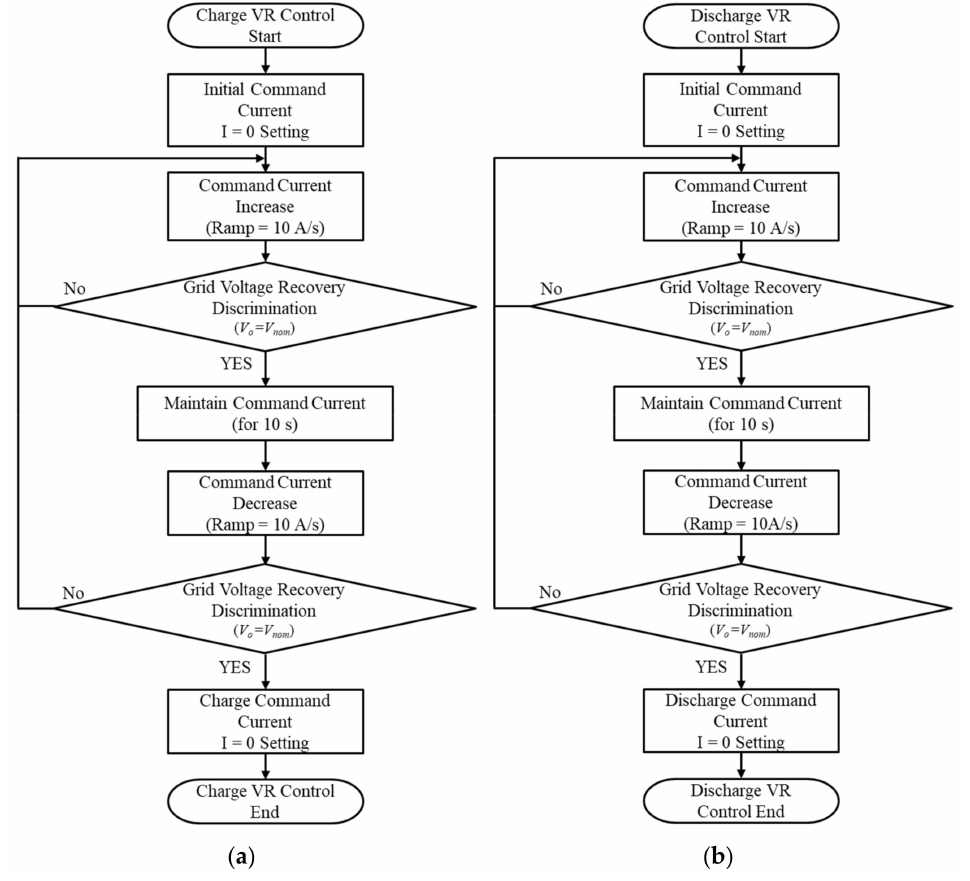
Figure 10. Flowchart of DC bus voltage regulation: ( a ) under- and ( b ) overvoltage